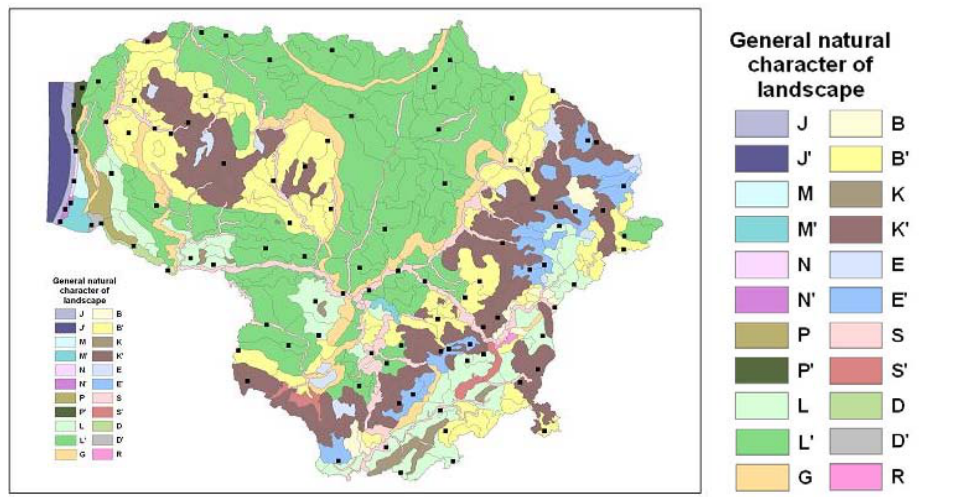
Fig. 7 . Distribution of landscape sample areas (black squares) in different landscape types of Lithuania (map according to: Lietuvos Respublikos…, 2006). General natural character types of landscape: J – marine landscape in the coastal zone (at a depth of < 20 m); J‘ – underwater plateaus and troughs; M – shallow lagoon (at a depth of < 2 m); M‘ – deep lagoon; N – smoothened spit; N‘ – rugged spit; P – lagoon coastal plain; P‘ – sandy coastal plain; L – continental sandy plains; L‘ – clayey plains; B –